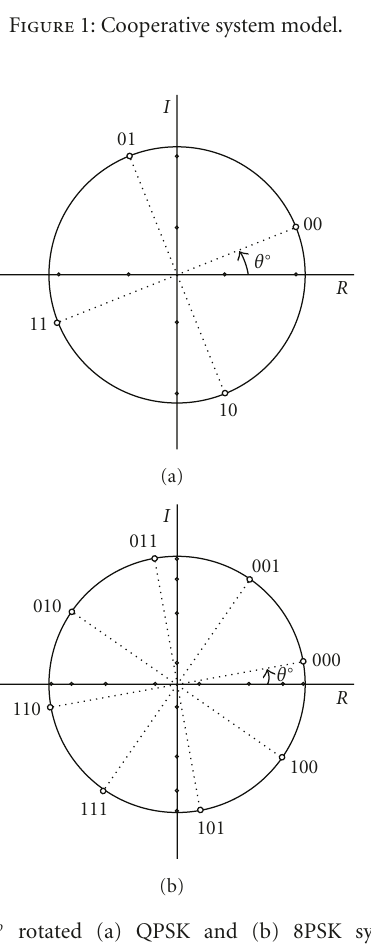
Figure 2: θ o rotated (a) QPSK and (b) 8PSK symbols and corresponding bit